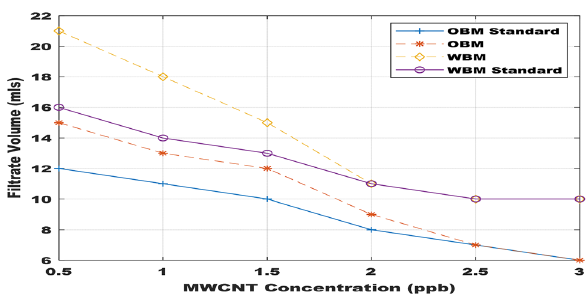
Fig. 6 Comparison of fluid loss at different concentrations of stand- ard and MWCNT for OBM and